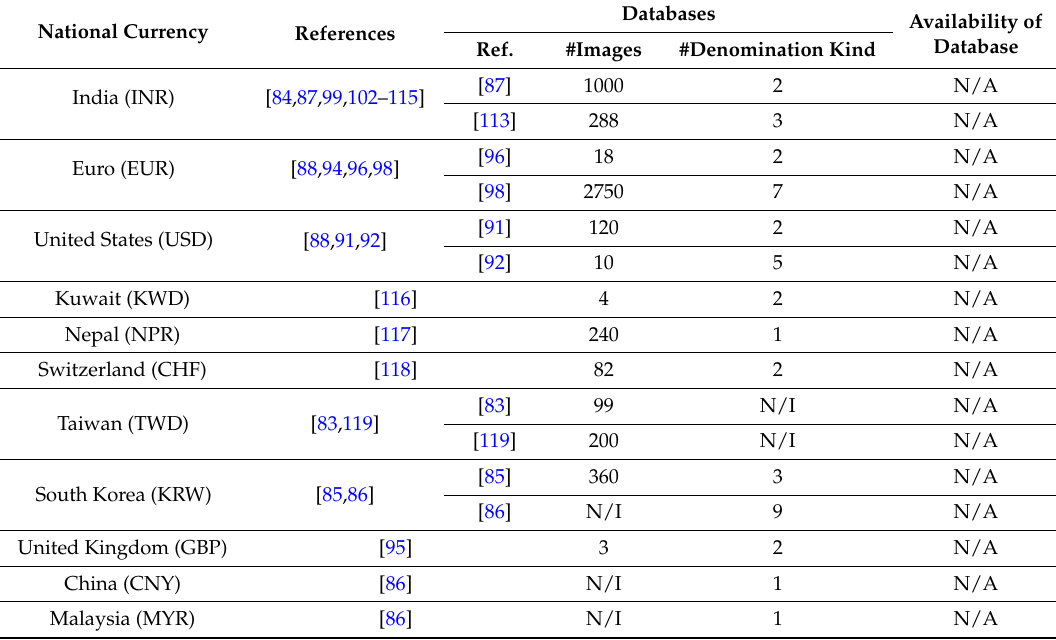
Table 7. Studies on counterfeit banknote detection by currency (Ref.: References, N/I: Not Informed, N/A: Not Available).